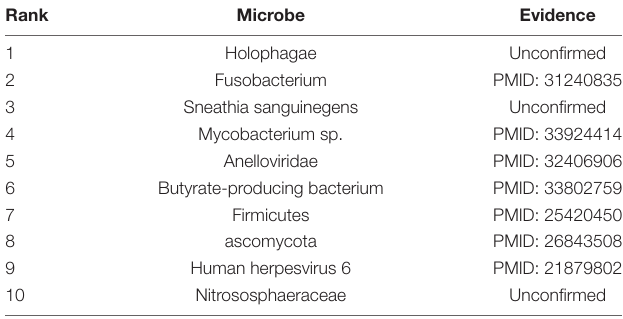
TABLE 3 | Top 10 candidate microbes related to IBD.